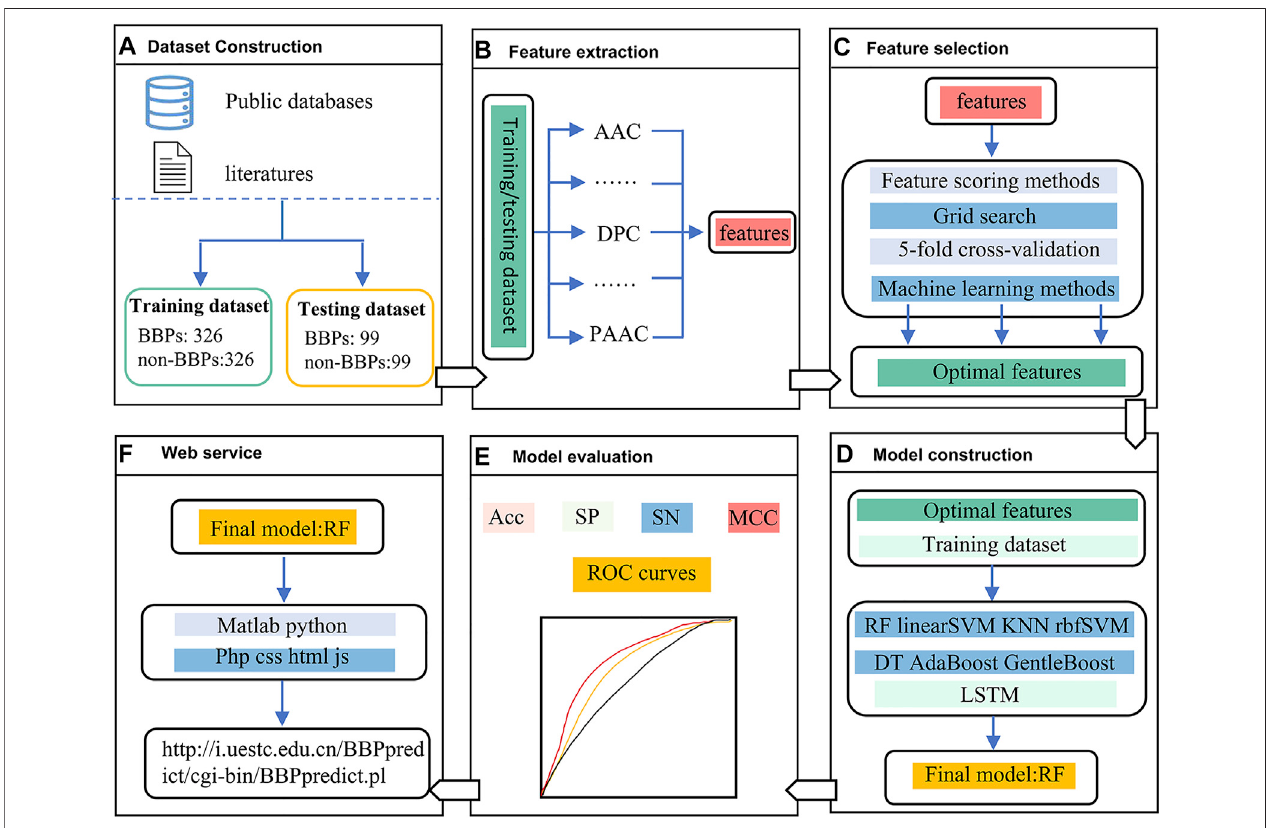
FIGURE1| TheframeworkofBBPpredict. (A) .DatasetConstruction. (B) .Featureextraction. (C) .Featureselection. (D) .Modelconstruction. (E) .Modelevaluation. (F) . Web service.